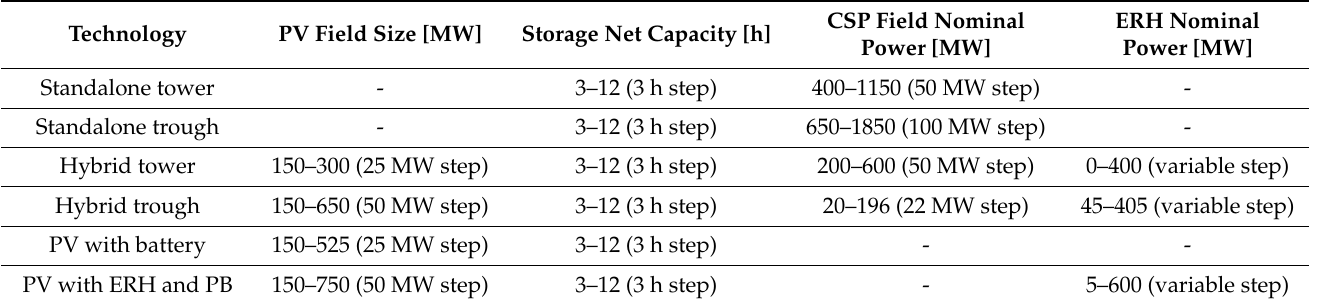
Table 2. Steps and limits of the parameter